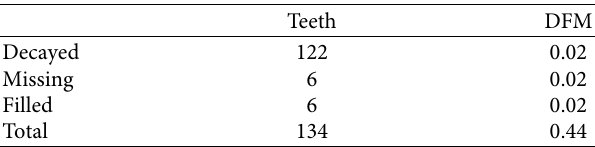
Table 3: DFMT index.